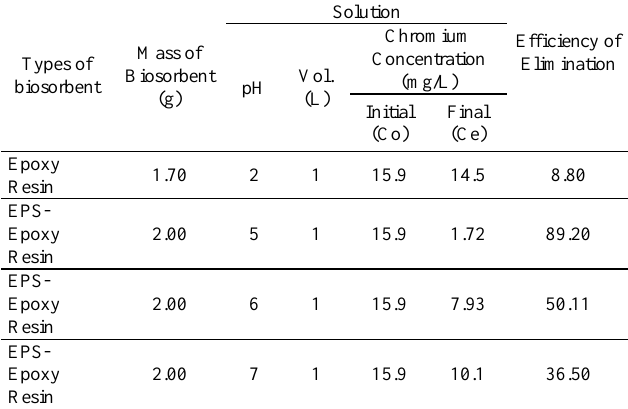
Table 3. Data of Chromium Sorption Capabilities of